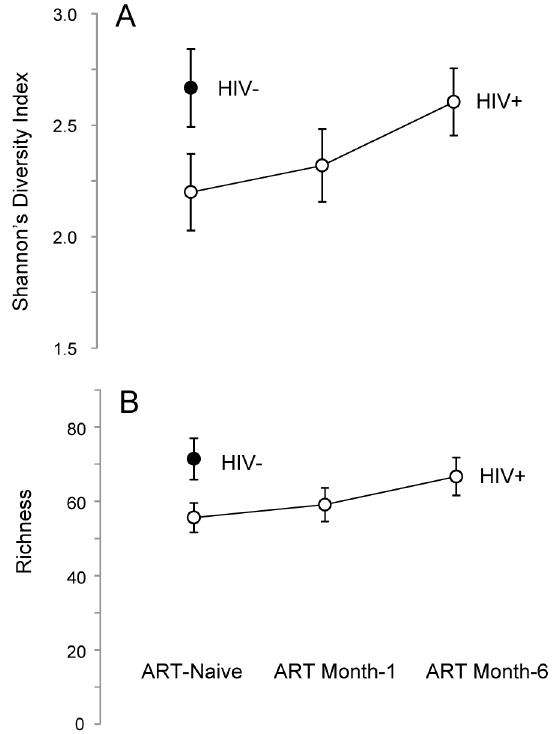
Figure 2. Semen microbiome biodiversity in uninfected versus HIV-infected men over the course of antiretroviral treatment. In this set of two plots ( Panels A–B ), the solid circles represent HIV- uninfected men, whereas open circles represent HIV-infected men. Panel A depicts the higher richness ( i.e. , greater number of unique bacterial types) of the semen microbiome in HIV-uninfected men, as well as the restoration of richness over the period of six months on ART. A similar trend was seen in semen microbiome diversity, as shown in Panel B.